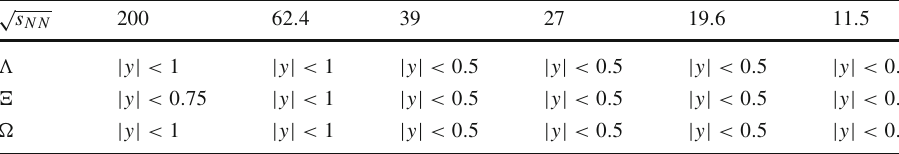
√ s NN is given in